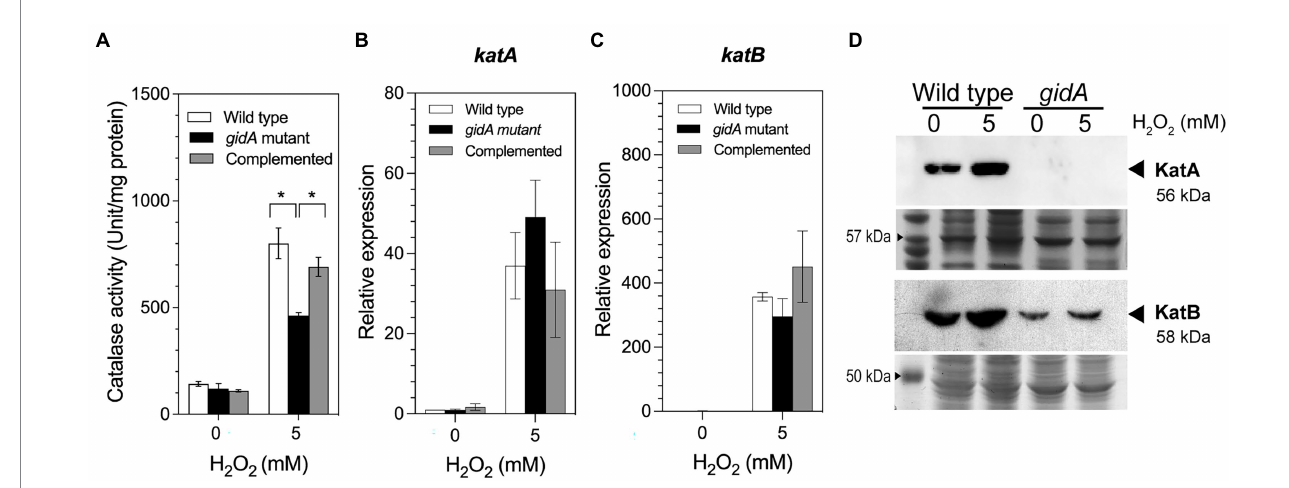
FIGURE 2 Impact of gidA disruption on catalase gene expression. (A) The catalase-specific activity of the wild-type, gidA inactivation mutant, and complemented strains. (B) Relative mRNA expression levels of katA , and (C) katB , in the wild-type, gidA mutant, and complemented strains upon H 2 O 2 exposure. The wild- type and gidA mutant carried the pBBR1MCS-4 plasmid as a vector control. The data represent the mean ± SD values of three biological replicates for (A–C) . The statistical analysis was performed using Graphpad Prism (GraphPad Software). Asterisks denote a significant difference in the one-way ANOVA (* p ≤ 0.05). (D) Western blot analysis of the KatA and KatB proteins. Anti-KatA antibody was used to assess KatA level. The amounts of KatA and KatB proteins overexpressed from the pBB- katA -6xHis plasmid and pBB- katB -6xHis plasmids, respectively, were assessed using the anti-His antibody. The amount of total protein loaded in each gel is shown as the loading control. The data shown are representative results of three biological